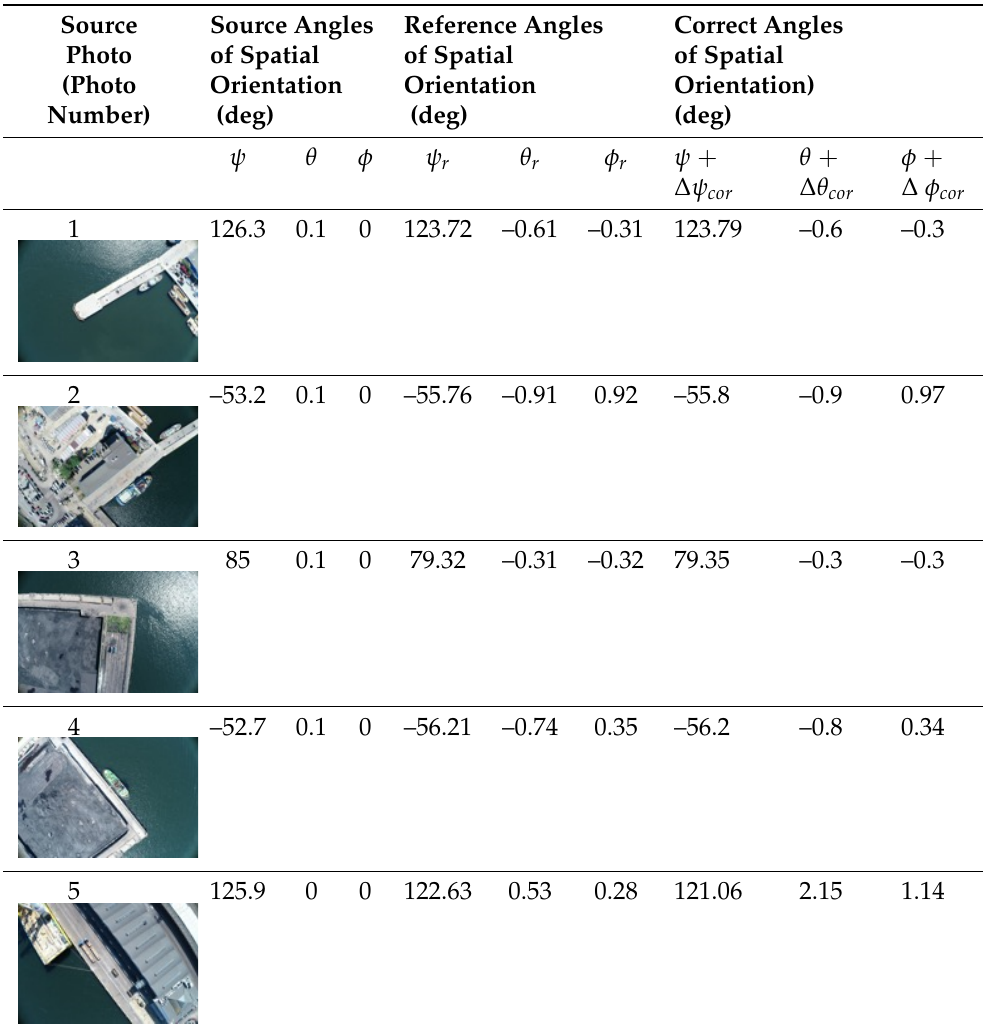
Table 2. A comparison of five photos with the designated values of three types of spatial orienta- tion